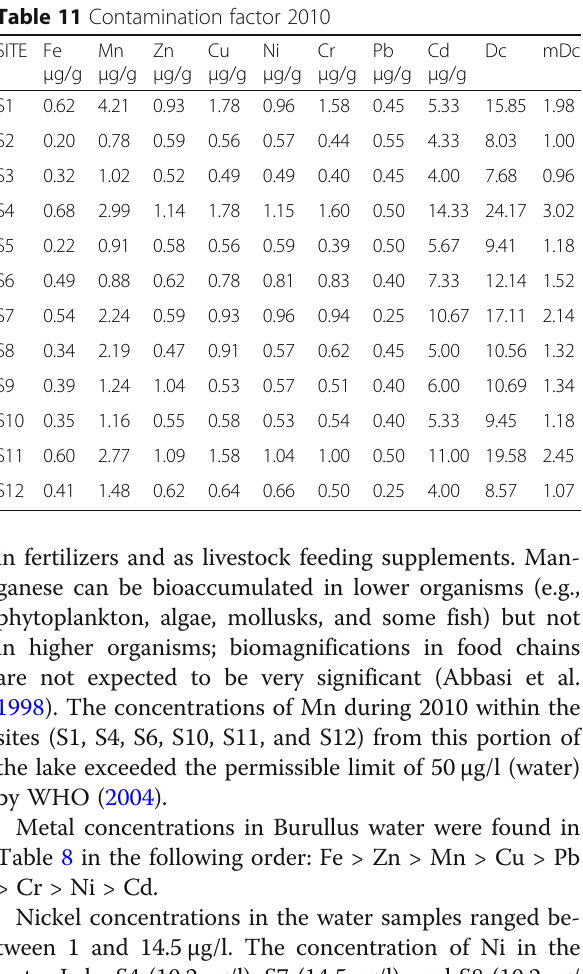
Table 8 in the following order: Fe > Zn > Mn > Cu > Pb > Cr > Ni > Cd.